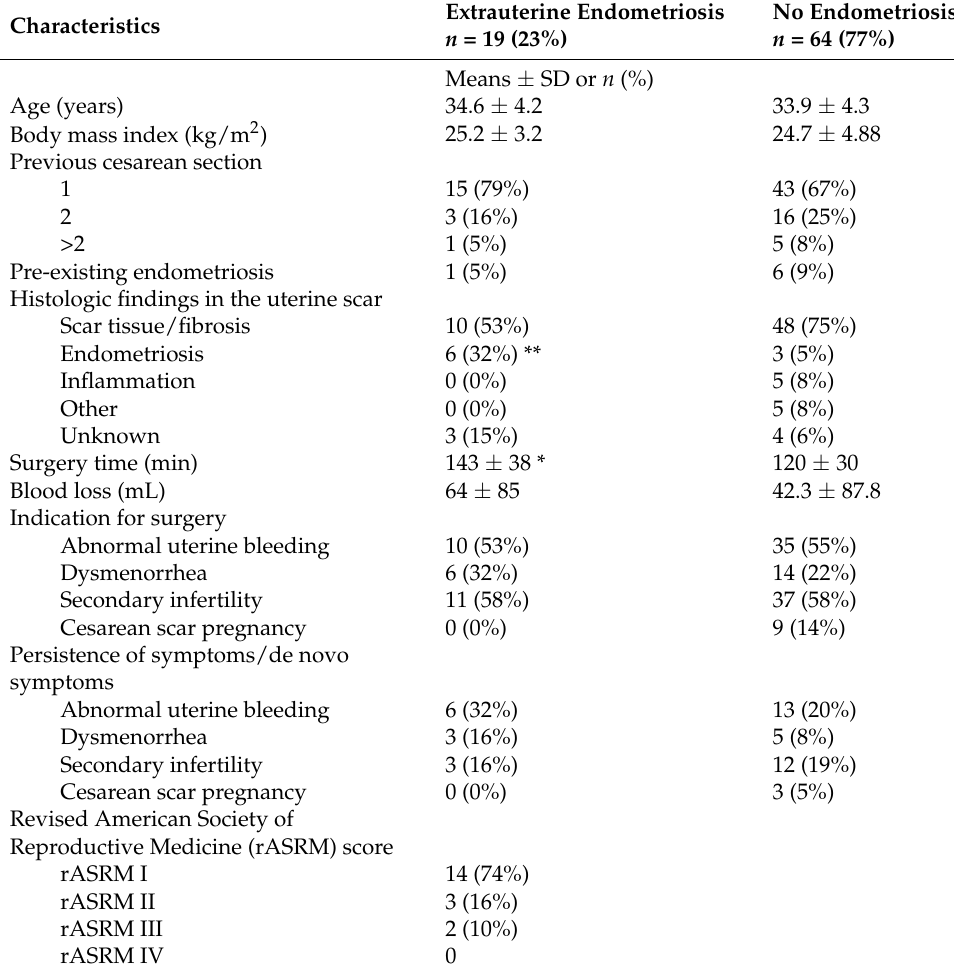
Table 2. Descriptive characteristics of patients with and without extrauterine